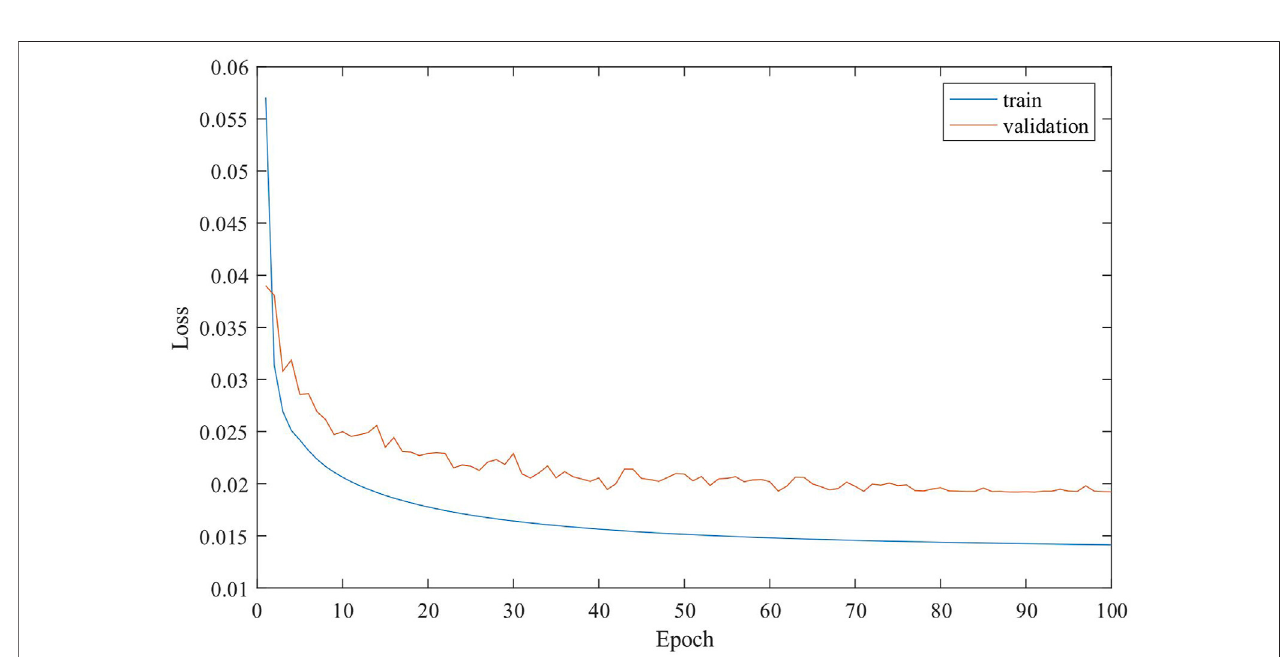
FIGURE 4 | Training loss and validation loss declining